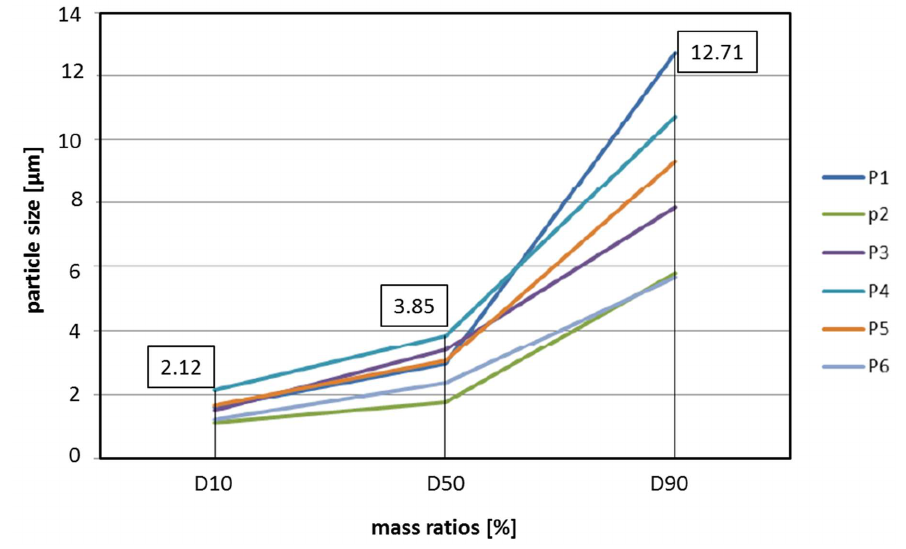
Figure 8. Grain size distribution of the Fe-Me phase of samples P1–P6.